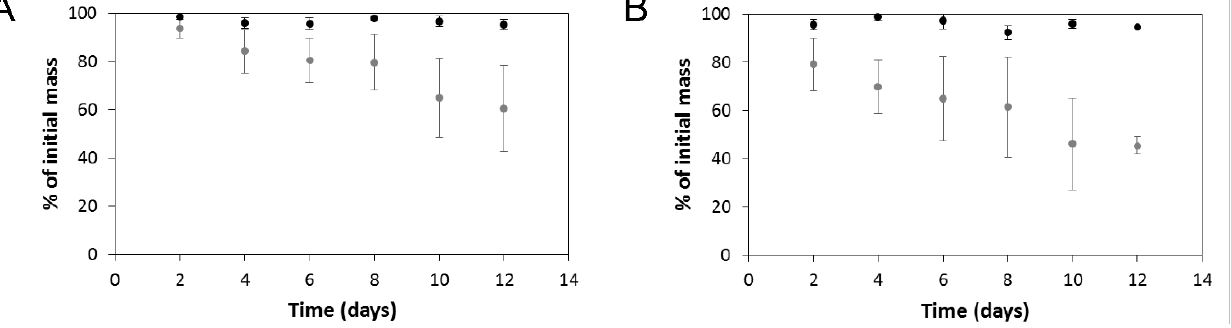
Figure 6. In vitro degradation profiles of the PCL-based tissue scaffolds in PBS. ( A ) Non-electroactive scaffolds: black circles in the absence of cholesterol esterase; grey circles in the presence of cholesterol esterase. ( B ) Electroactive scaffolds: black circles in the absence of cholesterol esterase; grey circles in the presence of cholesterol esterase. Error bars represent standard